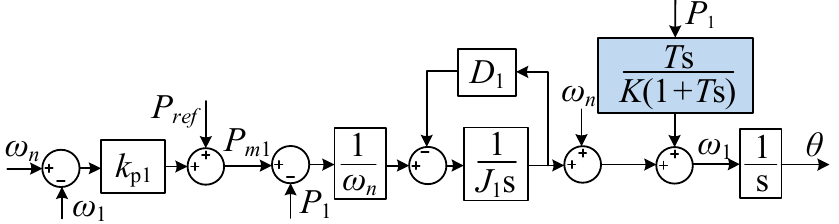
Figure 5. Active power control block diagram of VSG based on the first-order high-pass filter. According to Figure 5, the active loop control equation of the VSG after introducing the high-pass filter can be written as